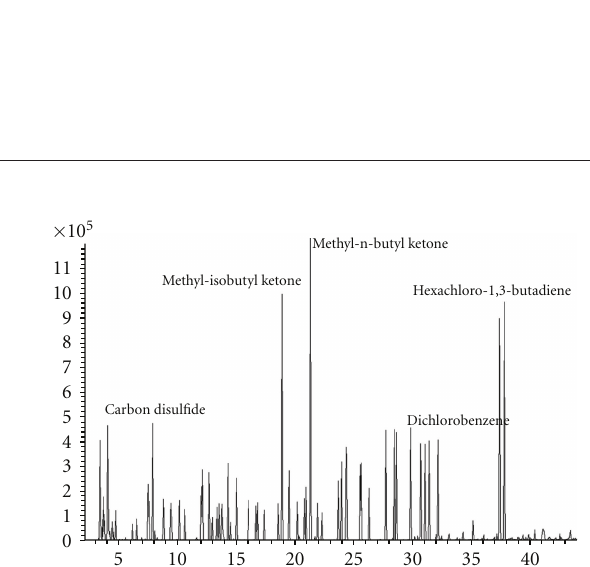
FIGURE 8: Sample equivalent to 1 L of a 2 ppb standard sampled using dual-bed sorbent tubes and analysed splitless using two-stage thermal desorption (TD-100, Markes International Ltd), method conditions shown in Table